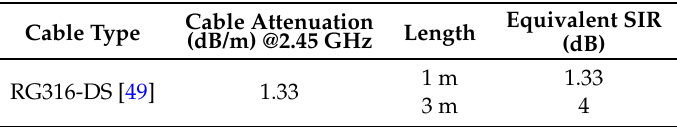
Table 6. Experimental SIRs obtained through applied RF cables.